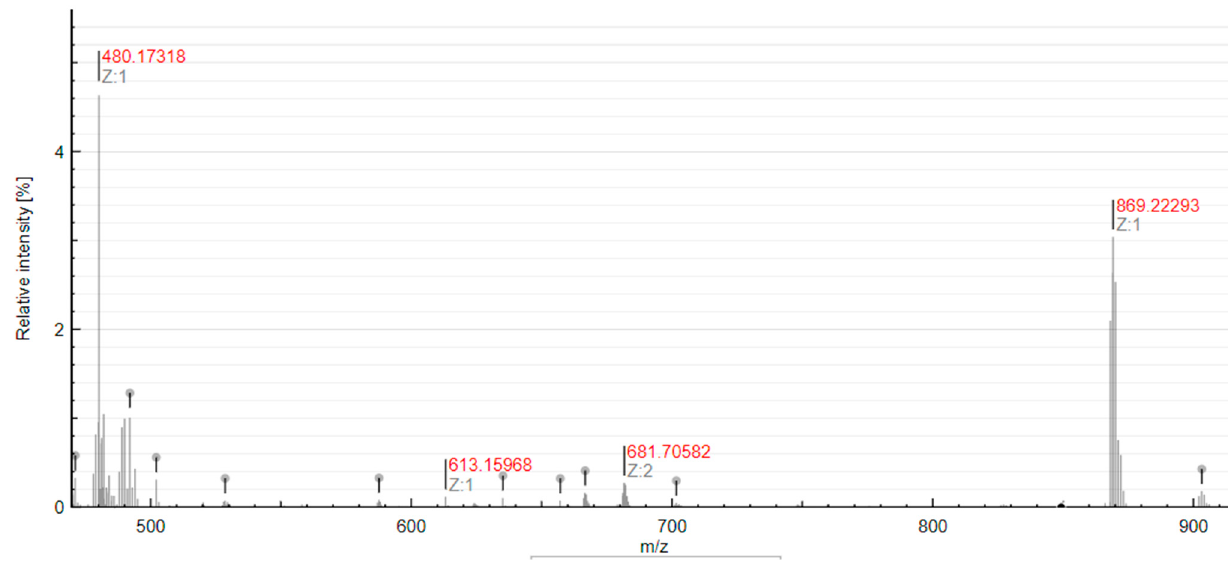
◦ 2 O:DMSO, recorded after 48 h at 37